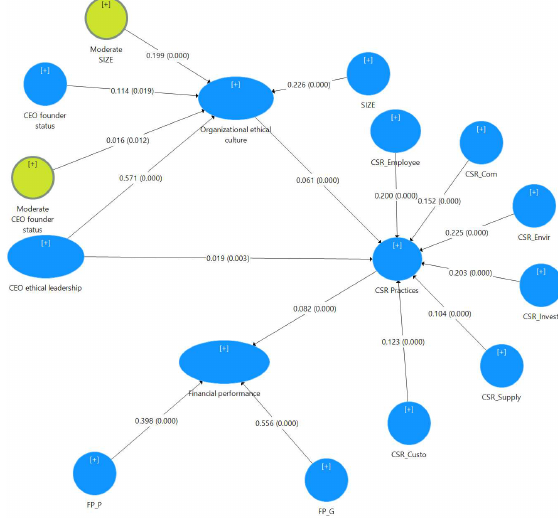
Fig. 3. Results of regulatory role inspection (PLS